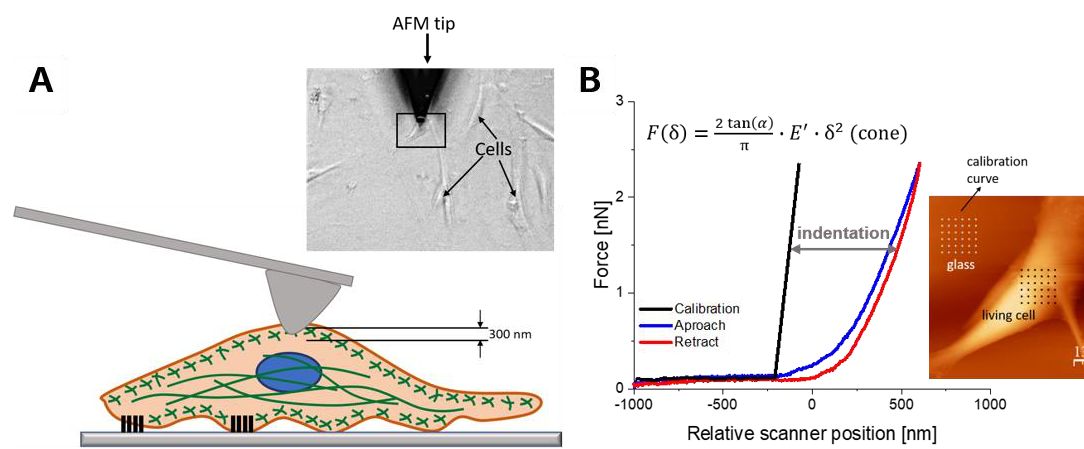
Figure 3. An idea of elasticity measurements using atomic force microscopy (AFM). ( A ): The illustration of the experimental method of AFM elasticity measurement on a living cell. ( B ): Force versus indentation curve was fitted with the Hertz—Sneddon mechanical model.